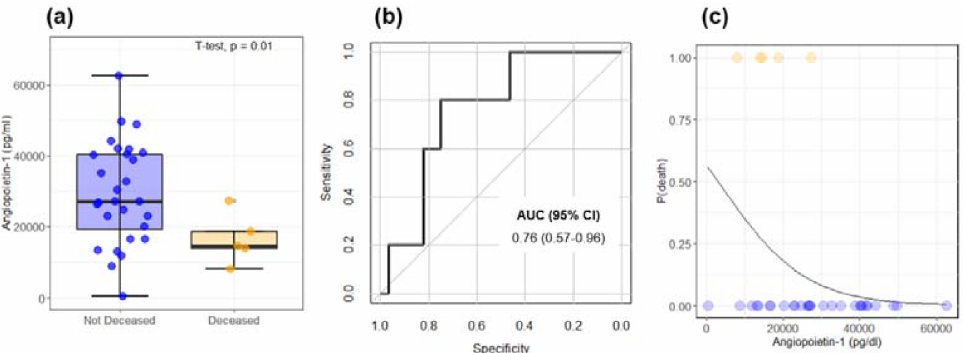
Figure 4. ( a ) Comparison between Ang-1 levels in deceased and not-deceased HCC patients. ( b ) Re-